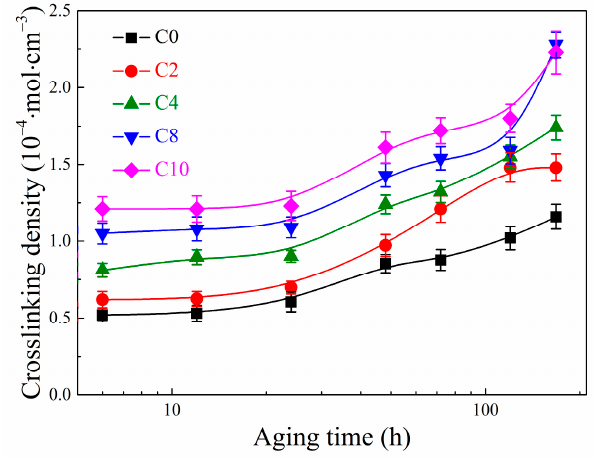
Figure 7. Crosslinking densities of EPDM composites at various aging